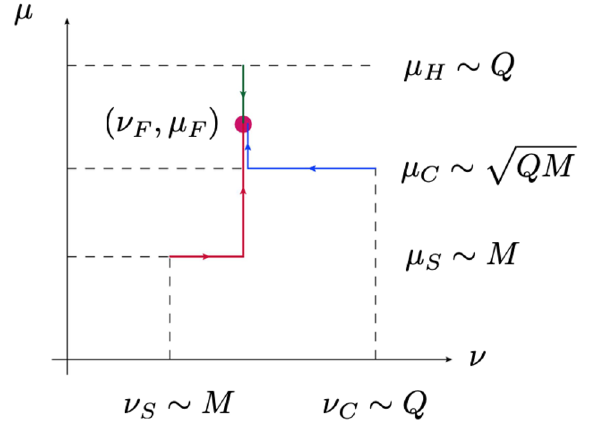
Figure 2 . The evolutions of the hard, collinear and soft functions start from their own characteristic scales µ H , ( µ C , ν C ), and ( µ S , ν S ) respectively. Since the order of the evolution is irrelevant, we first evolve the collinear and soft functions with respect to ν , and then µ . The path of the evolution is illustrated by the